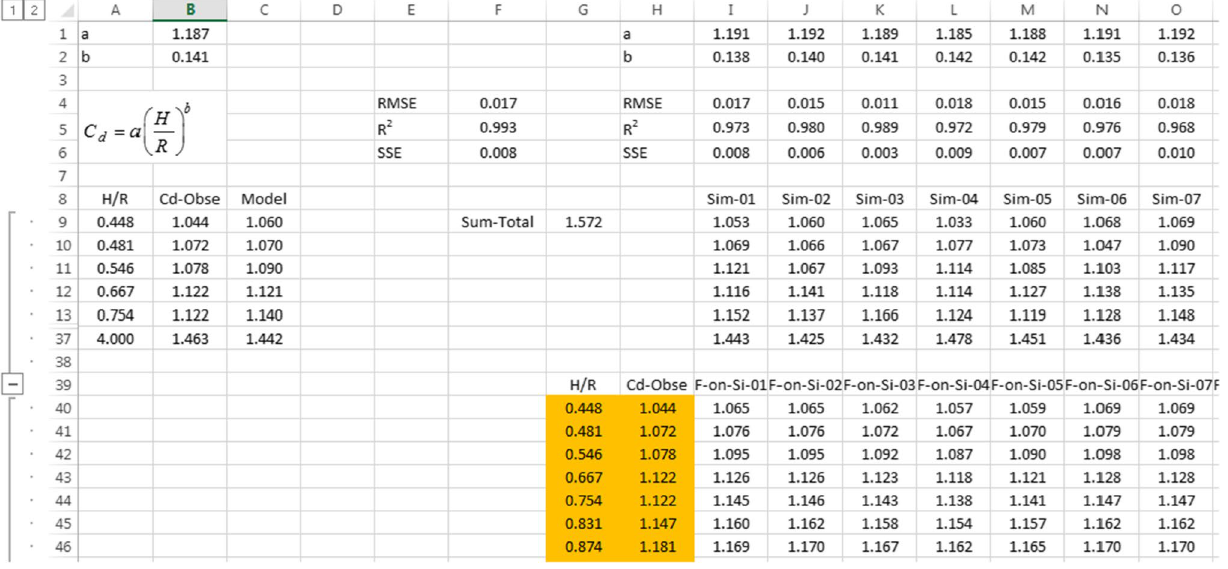
Fig. 3 The process of uncertainty analysis of Cd based on the MC method of circular crested